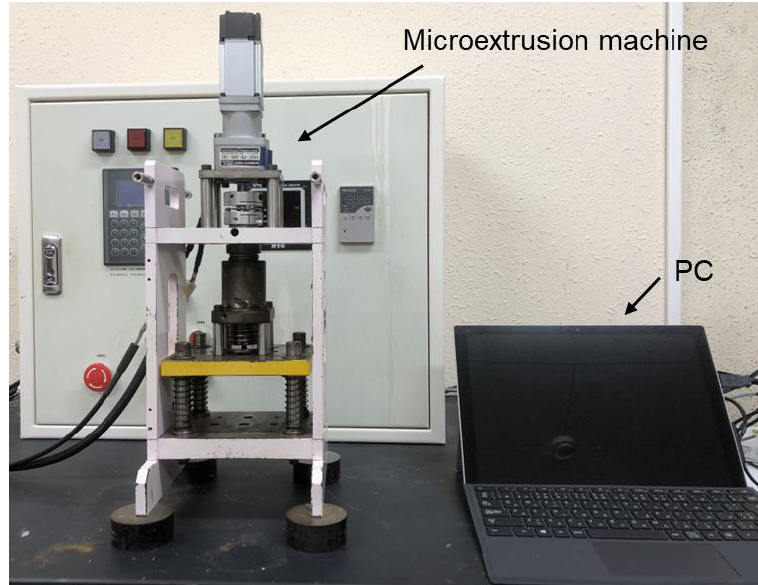
Figure 1. Photograph of the microextrusion machine [21]. A schematic of the die and punch used for this study is shown in Figure 2 [21]. The die was divided at the center to remove the billet after extrusion. Moreover, the die had a container inner diameter of φ 1.71 mm. The arithmetic mean roughness inside the con- tainer was Ra = 0.18 µm. The punch was selected for backward extrusion, and the diameter of the formed part was φ 1.47 mm, indicating that a bottomed microtube with a product diameter of φ 1.71 mm and wall thickness of 120 µm can be fabricated.